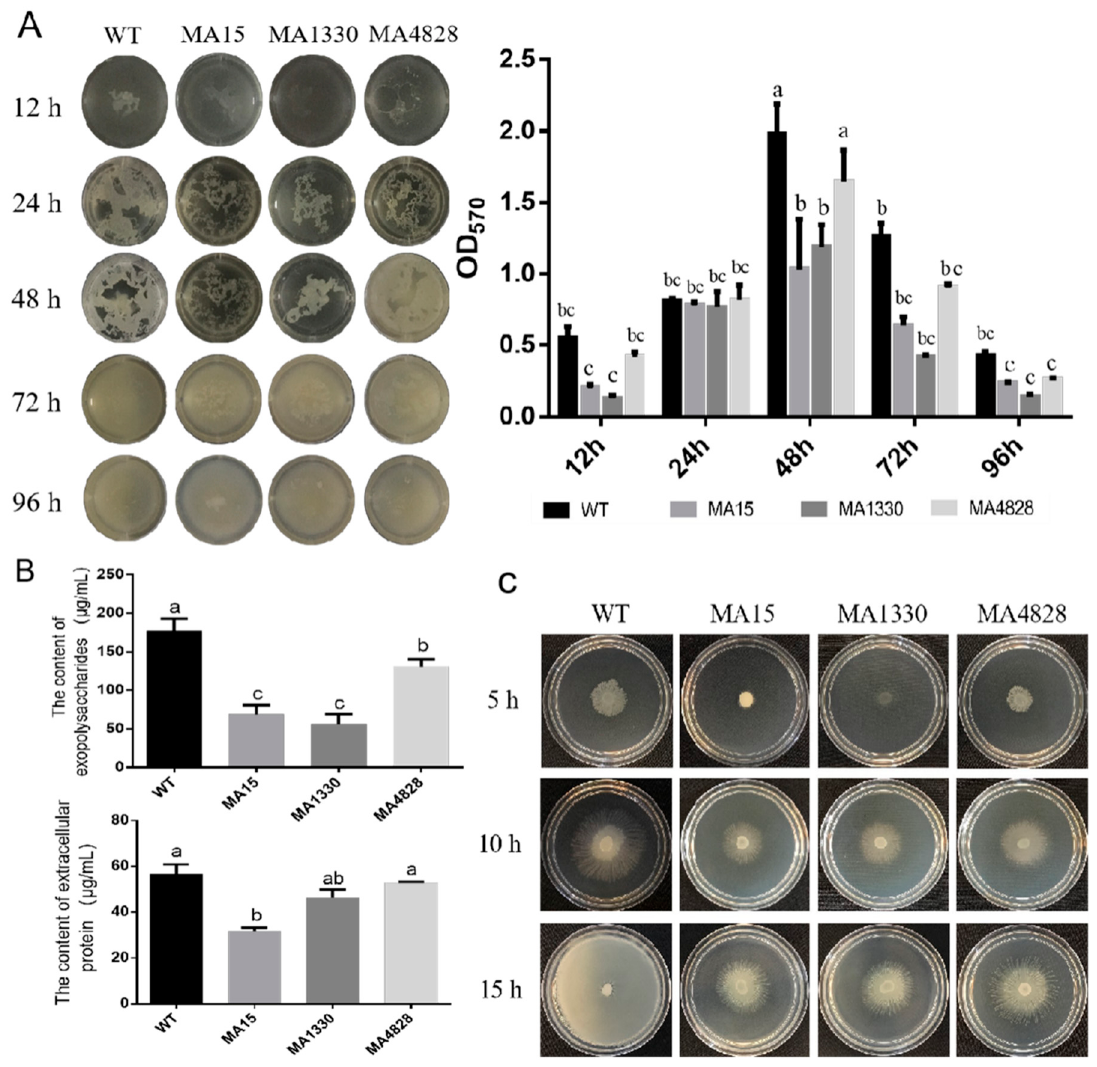
Figure 2. The biofilm-related features are significantly di ff erent between wild-type (WT) and mutants. ( A ) The biofilm architecture at the liquid–gas interface and the absorbance at 570 nm. ( B ) The contents of extracellular substances in LB medium at 48 h. ( C ) The swarming motility of cells of WT and mutants. Di ff erent letters above the bars indicate significant di ff erences ( p <